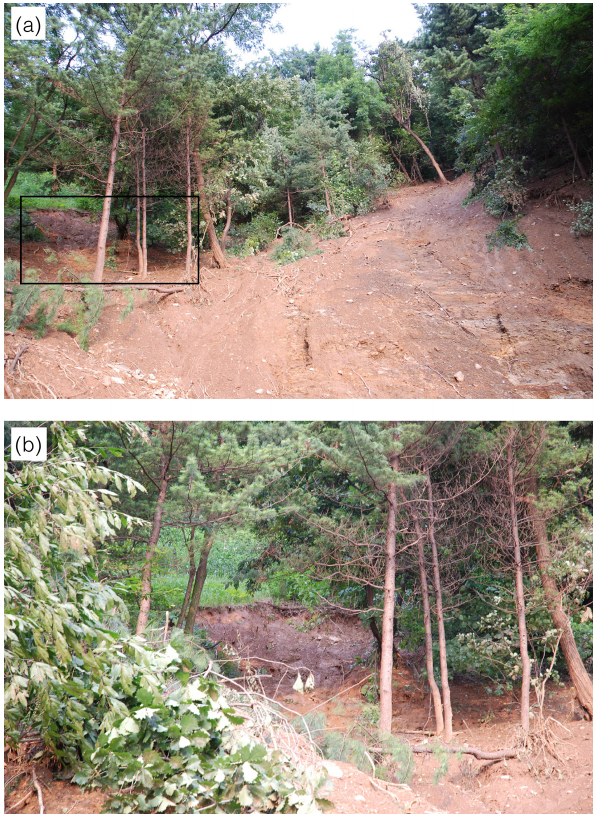
Figure 6. Landslides in Site C. (a) Landslide initiation zones, look- ing northeast. An area outlined by a black solid line presents a closer look of one of the initiation zones in slopes (b) . (b) A closer look of the landslide initiation zone indicated in (a) .